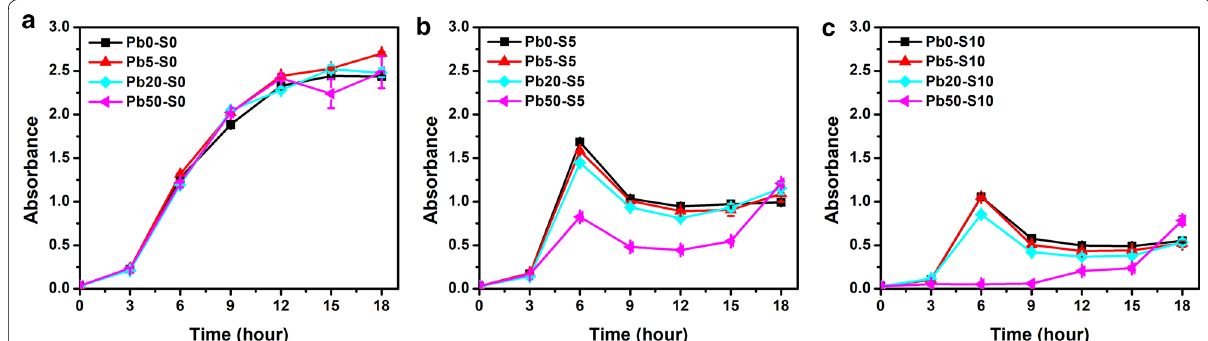
Fig. 3 Growth curves of the chassis cells with the selection plasmid in response to lead and sucrose. The optical density at 600 nm of the E. coli (pZE21-PBS) strain was measured with lead at different concentrations of 0 µM (squares), 5 µM (up triangles), 20 µM (diamonds), and 50 µM (left triangles). Sucrose was used at of a 0 g L − 1 , b 10 g L − 1 , and c 20 g L − 1 . Experiments were performed in triplicate, and data represent the averages and standard deviations of the